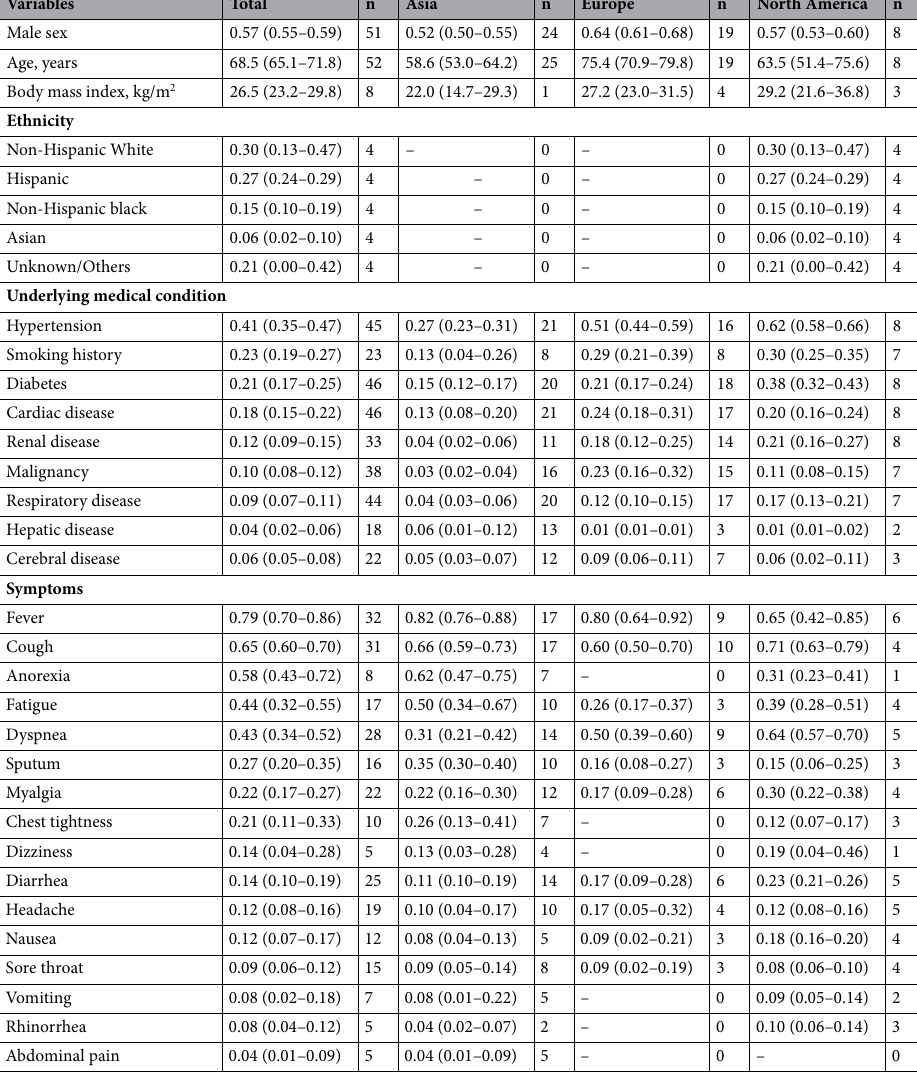
Table 2. Summary of patient characteristics according to the continents of the studies performed. Numbers are presented as pooled value with 95% confidence intervals. Values represent proportions unless specified otherwise. n numbers of studies included in calculating the pooled value in the previous